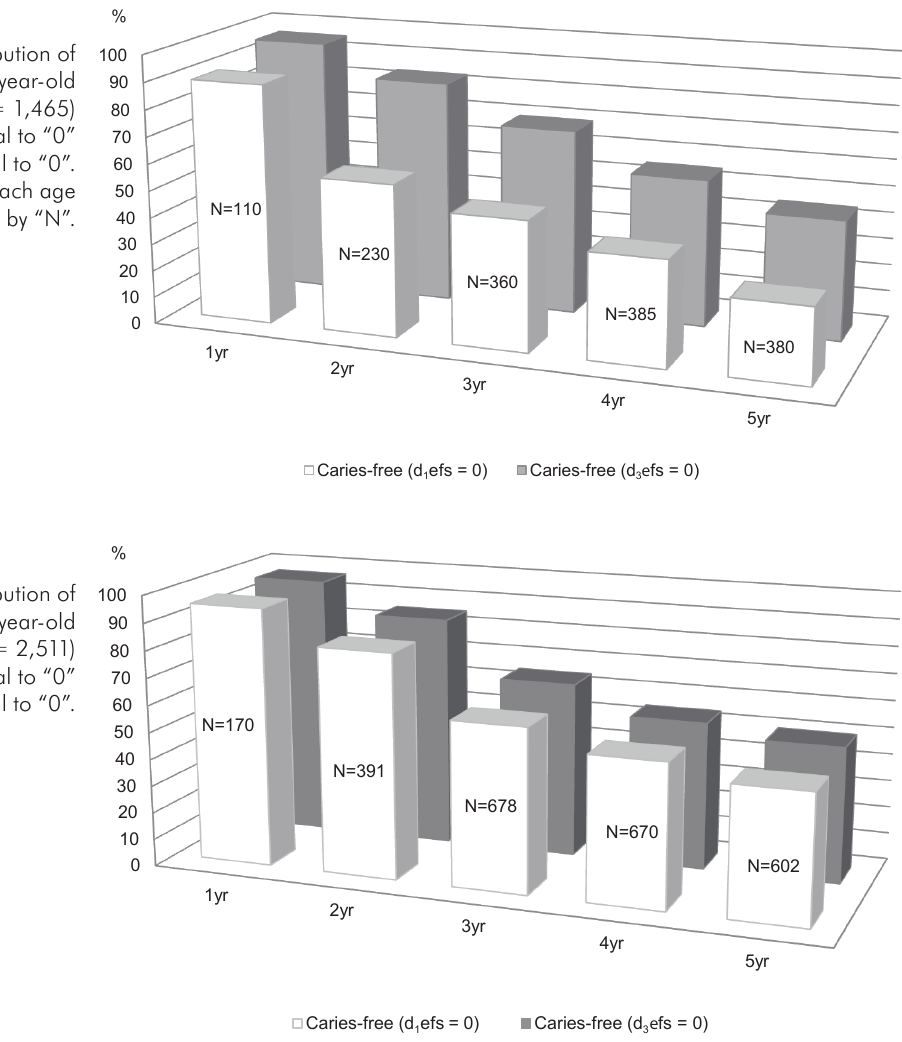
Figure 2 - Percentage distribution of caries-free Brazilian 1- to 5-year-old children in Cohort 2006 (n = 2,511) with their d efs scores equal to “0” 1 and their d efs scores equal to “0”. 3